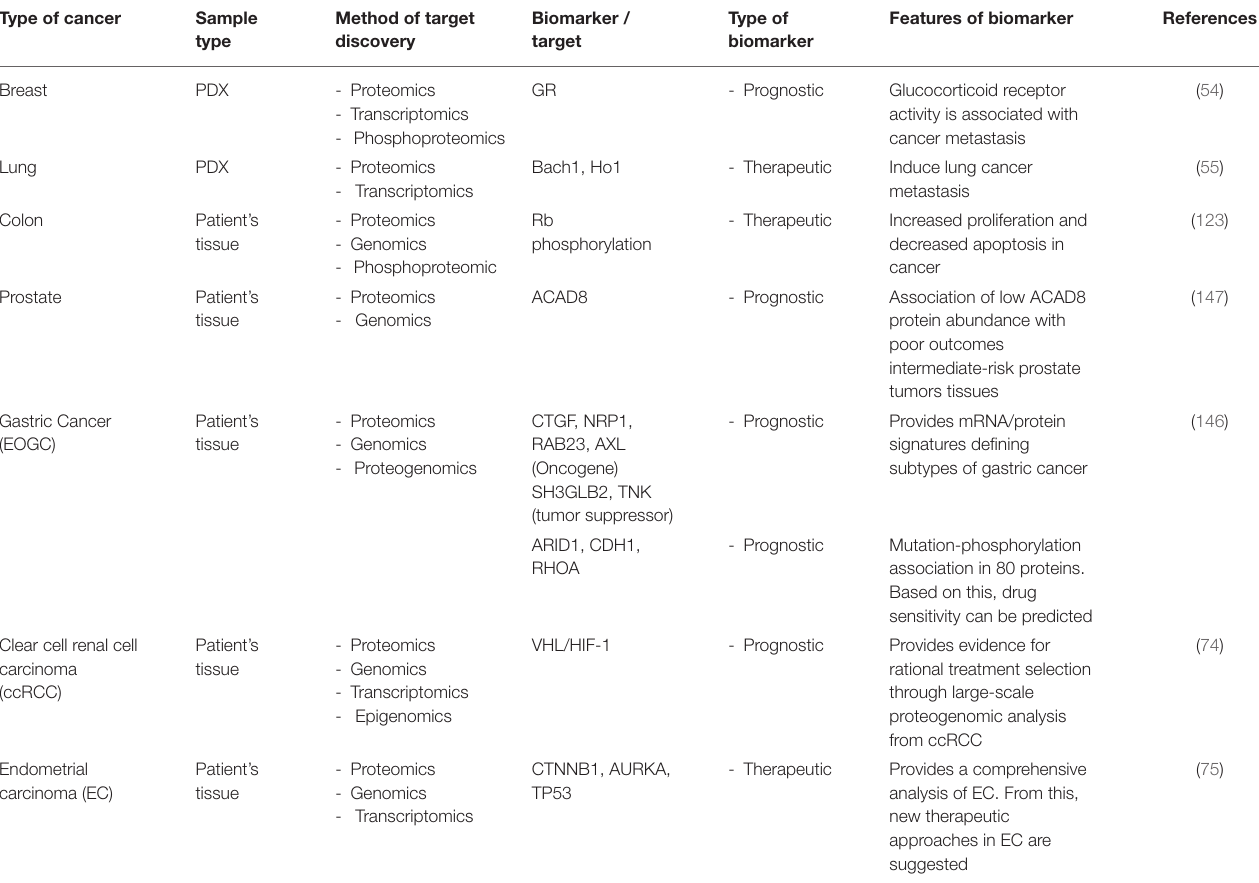
TABLE 6 | List of biomarkers in various cancers identified using multi-omics approaches. Type of cancer